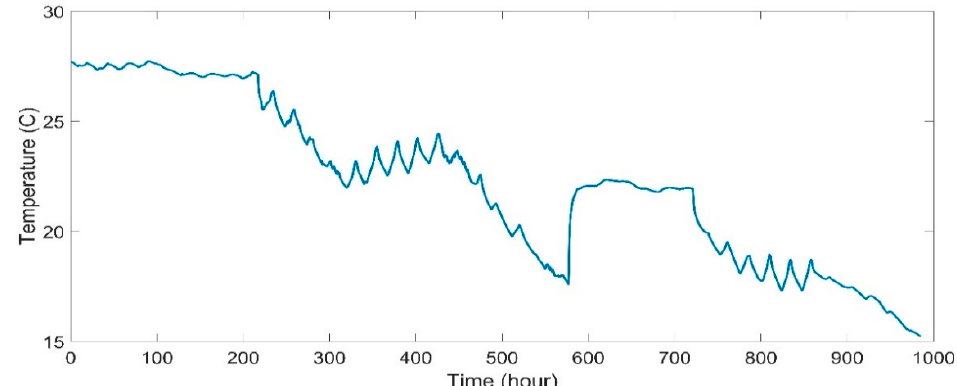
Figure 6. Measured indoor temperature for a building calculated from presented data in [28].